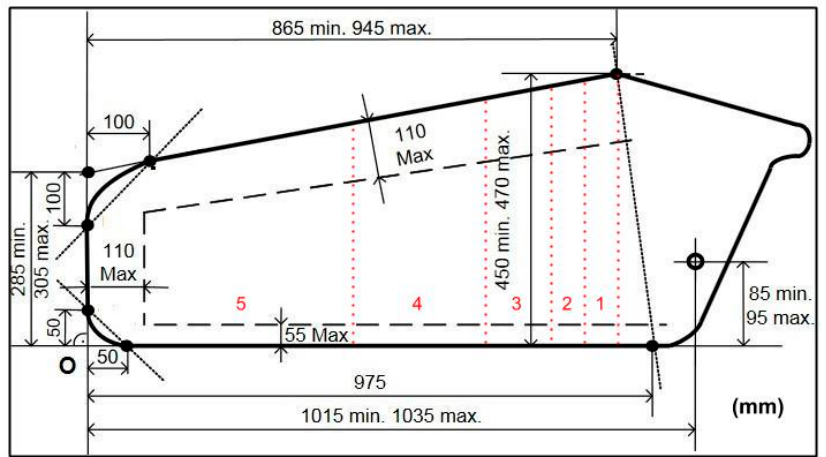
Figure 2. Dimension constraints on the centerboard [3]. Red numbers and lines show the five sector partitioning described in Section